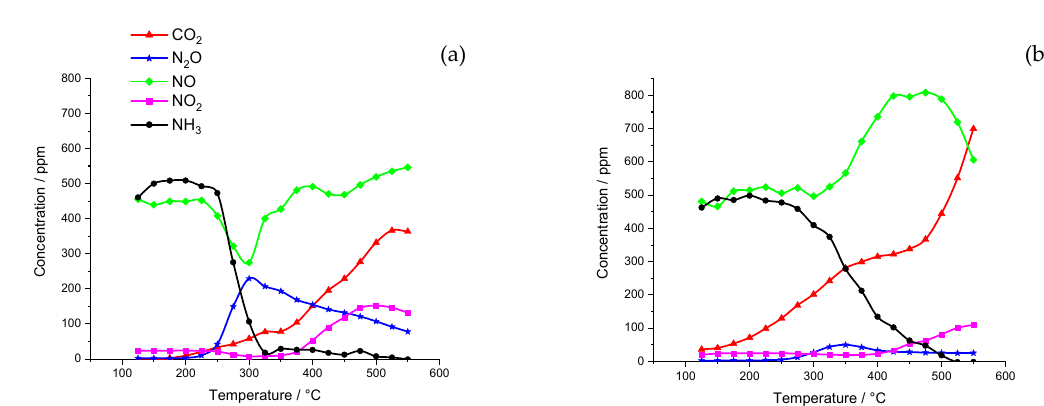
Figure 3. Reaction data for incipient wetness catalyst where the simulated exhaust gas consisted of 500 ppm NO, 500 ppm NH 3 , 8% O 2 , and N 2 as the balance gas. The temperature was increased in 25 ◦ C intervals from 125 to 550 ◦ C. ( a ) catalyst only reaction data, and ( b ) catalyst and soot data.